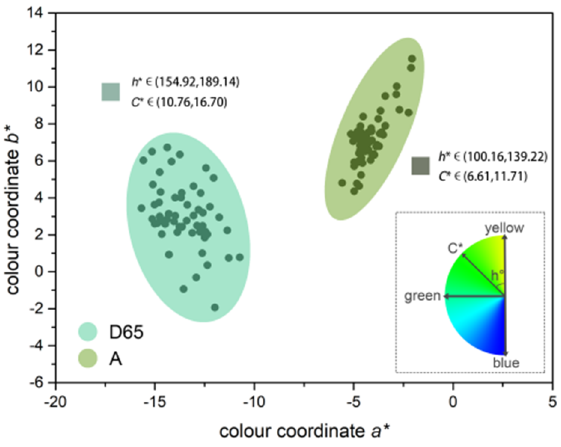
Figure 8. Chromaticity values of serpentinite samples under different light sources based on CIE1976 L*a*b* measured by the computer vision system.